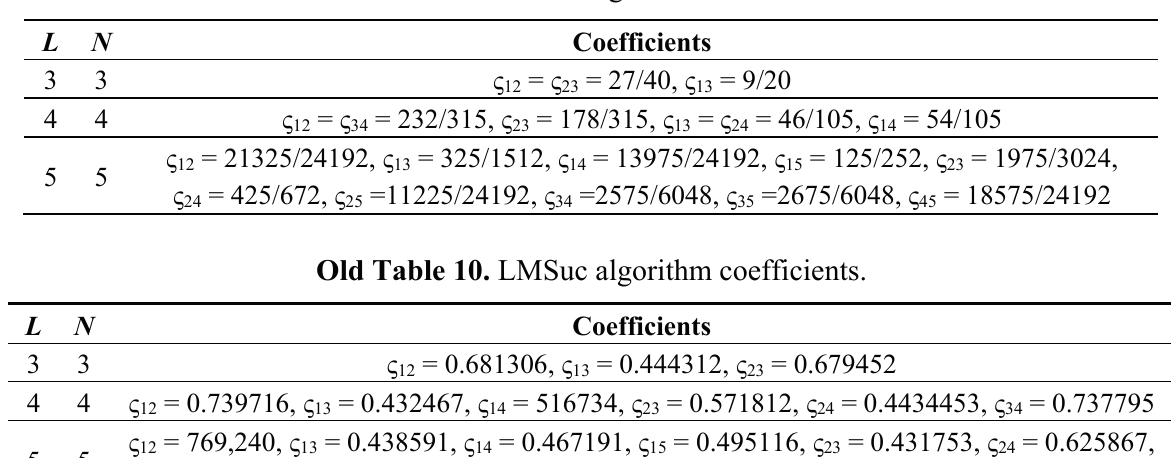
New Table 9. FTSuc algorithm coefficients.